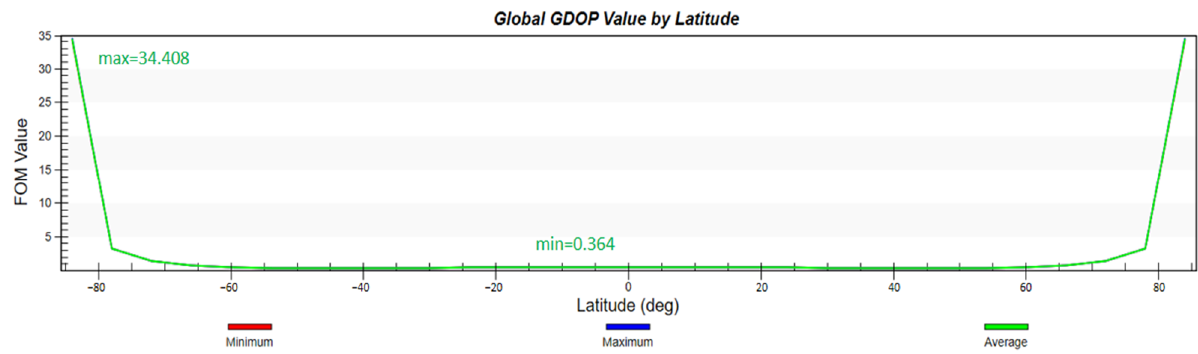
Figure 8. Global GDOP by latitude.